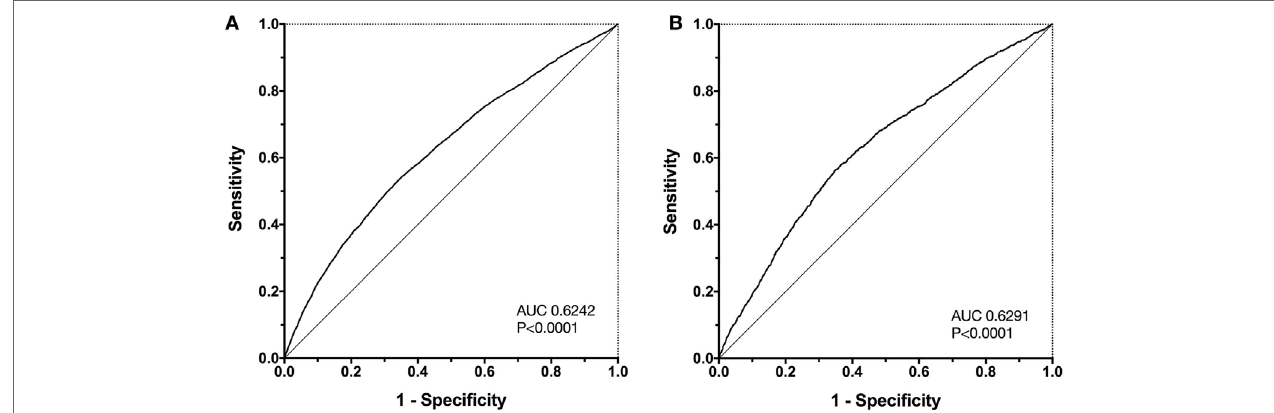
FigUre 6 | Receiver operating characteristic (ROC) curves for the survival probabilities as calculated by the final four-parameter multivariable model. Panel (a) displays the ROC curve for the initial population ( n = 33,117). The area under the ROC curve (AUC) is 0.6242, significantly different from 0.5 ( P < 0.0001). The same multivariable model was then used to predict outcomes in a separate test population of dogs from the same institution ( n = 11,249), panel (b) . In the test population, the AUC was almost identical to that in the original population AUC 0.6291, significantly different from 0.5 ( P < 0.0001).